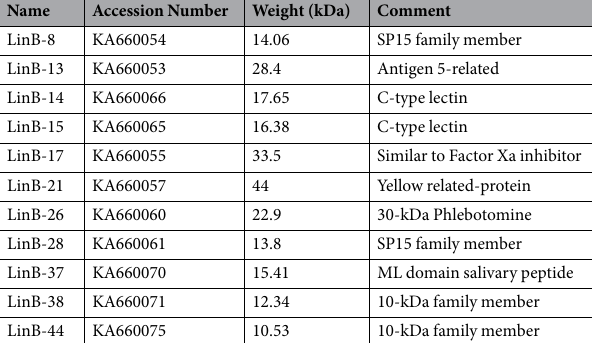
Table 1. Panel of Lu. intermedia recombinant salivary